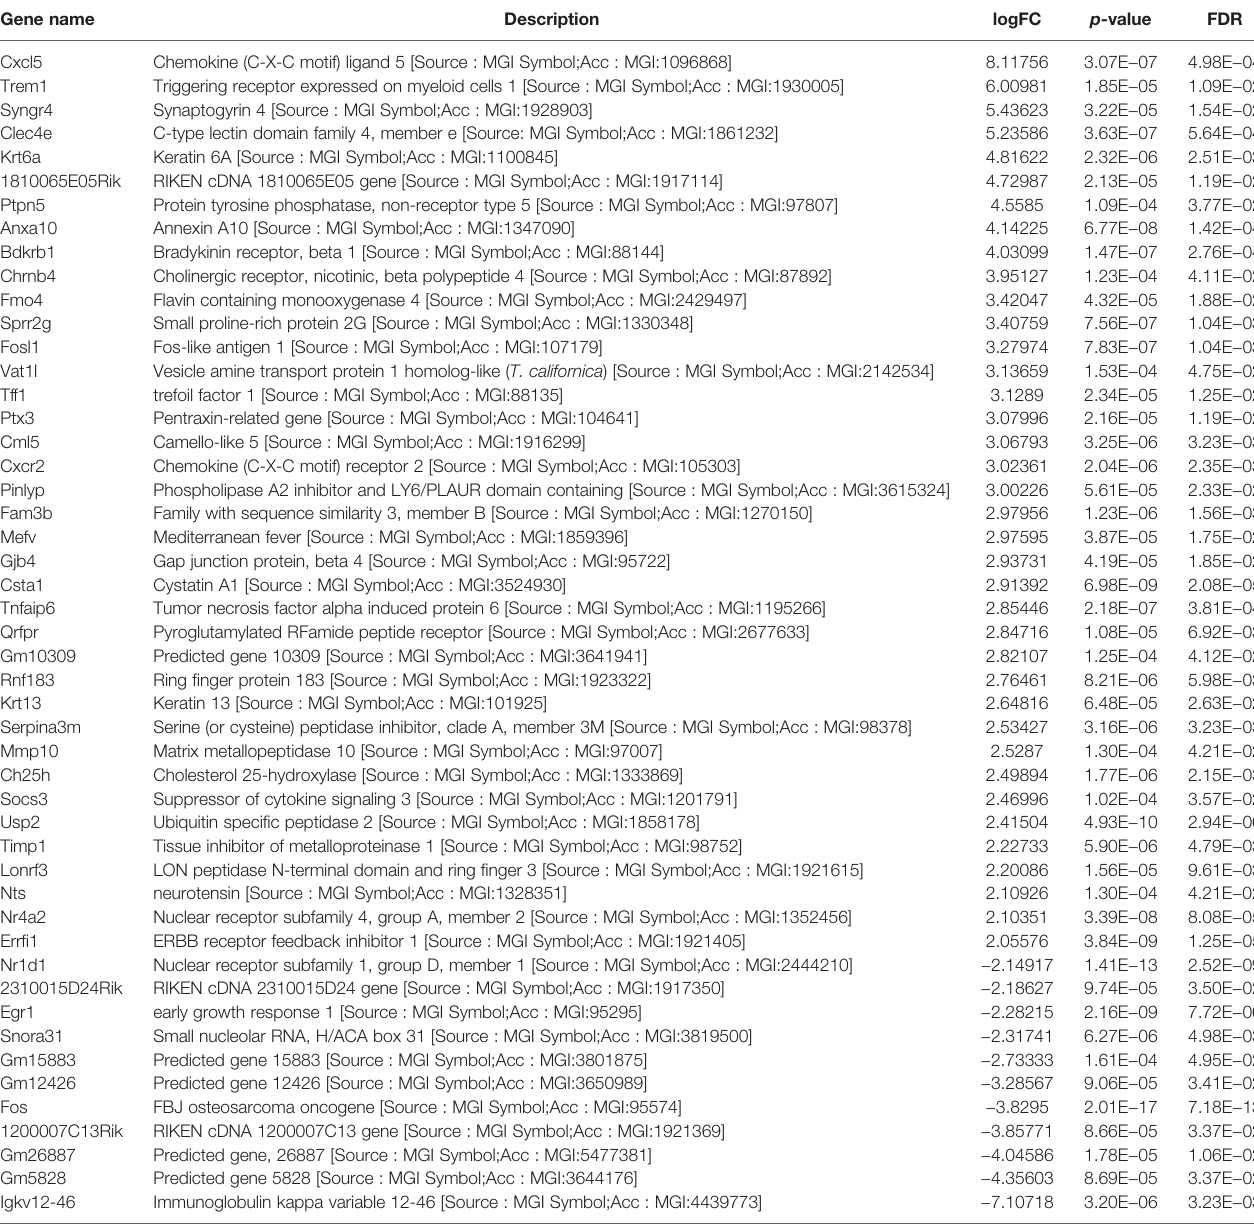
TABLE 1 | Genes differentially expressed in the bladder after two Gardnerella